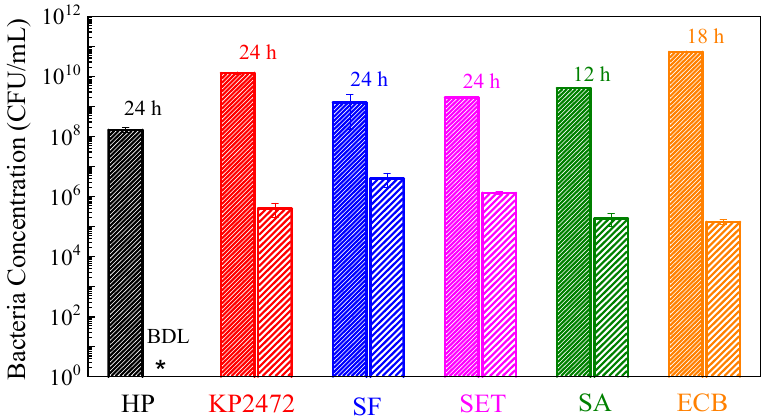
Figure 6. Bacterial inhibition tests: co-culturing bacteria with 1 mg / mL Cu x Fe y O z NPs in corresponding growth media. The results represent 3 independent growth experiments and are expressed as mean and standard deviation of CFU / mL (at the time indicated above each column). BDL: below detection limit ( < 200 CFU / mL). For each bacterial species, the bacterial concentration after Cu x Fe y O z treatment is significantly lower compared to the bacterial concentration obtained without treatment ( p < 0.01, Student’s t test).